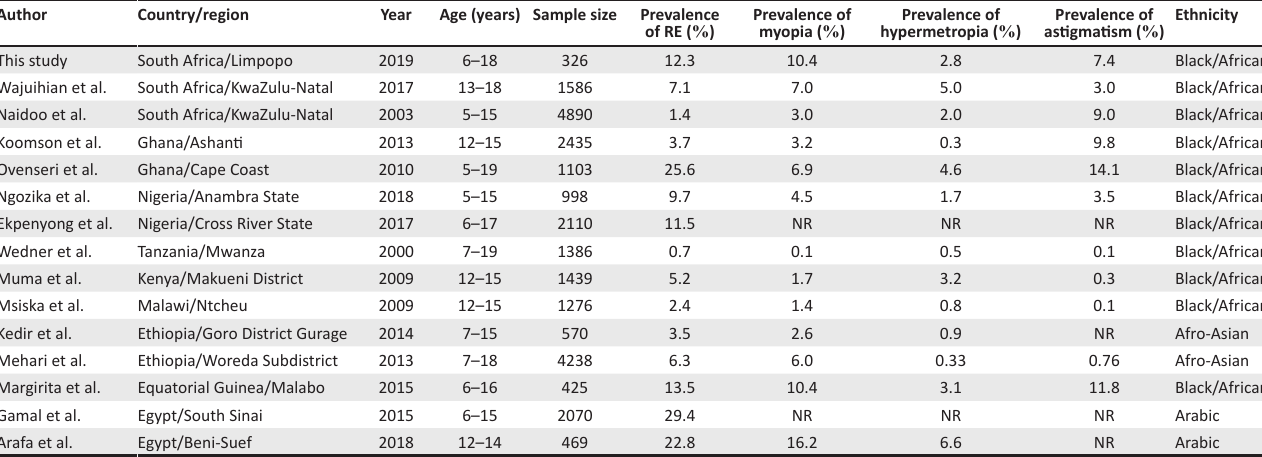
TABLE 1: Prevalence of refractive errors in African